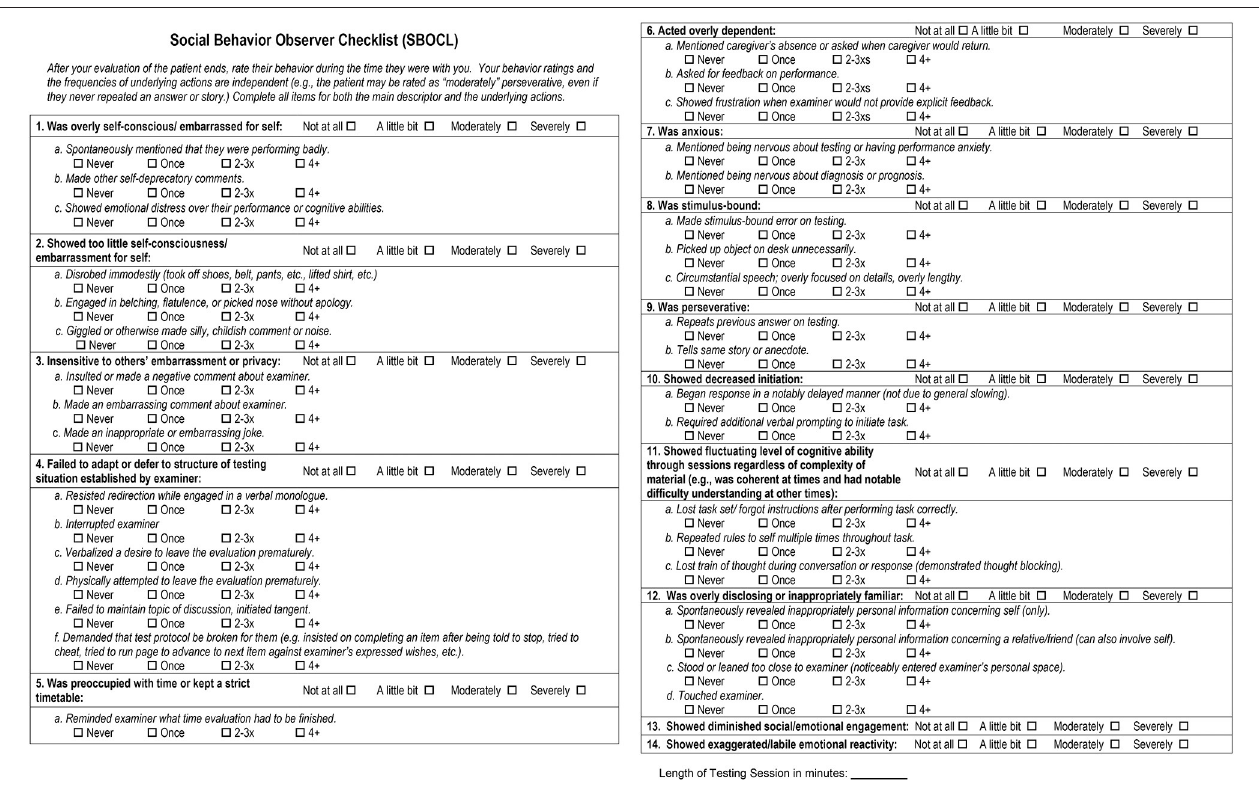
FIGURE 4 | Social behavior observer